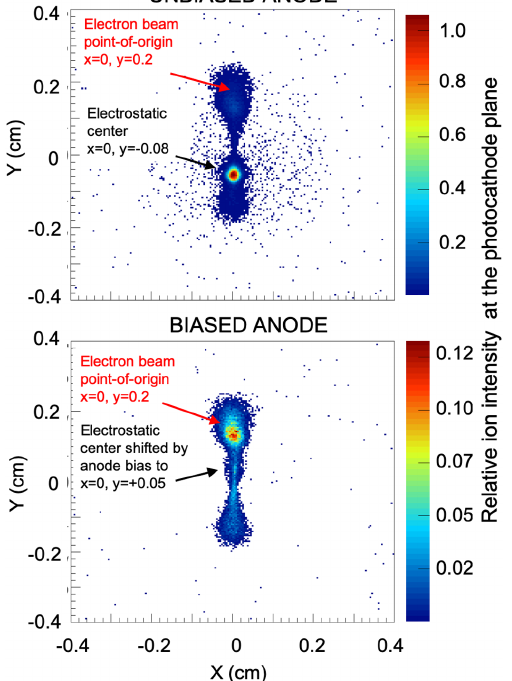
FIG. 14. IBSIMU results showing the number of primary ions impacting the photocathode for two conditions: unbiased anode (top) and anode biased at þ 1000 VDC (bottom). In both cases, the electron beam was extracted 0.2 cm above the photocathode